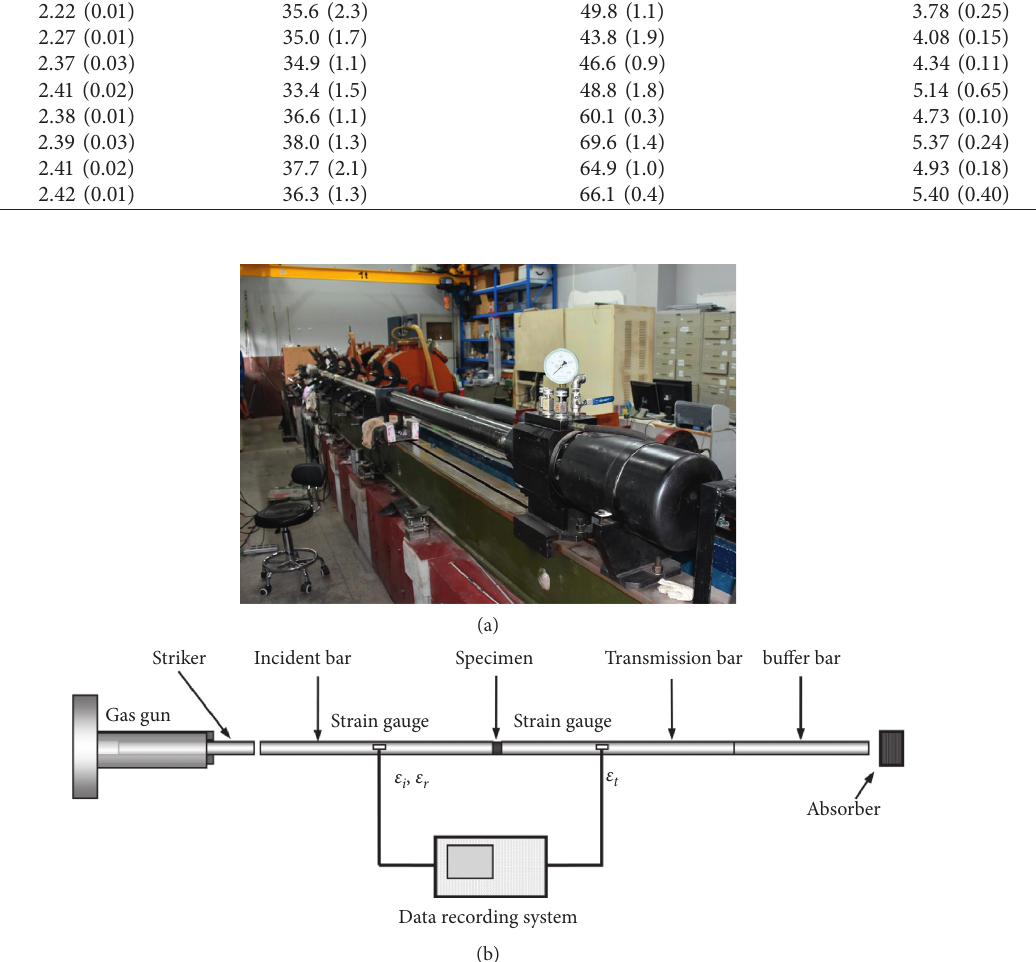
Figure 3: The SHPB setup: (a) photo of the device; (b) schematic diagram of the device.